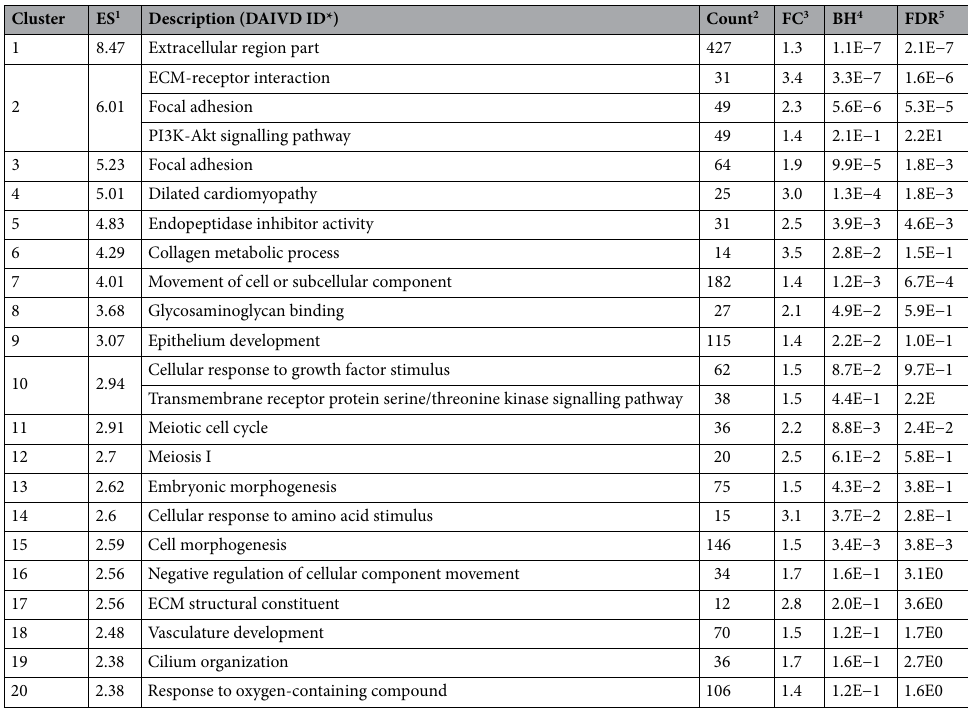
Table 1. Functional annotation clusters identified during the PrF-PF transition in domestic cat using DAVID. The top 20 categories grouped by similar GO and KO terms are listed. The full list containing 137 identified clusters is found in Supplementary Data 2, “DAVID PrF-PF”. 1 enrichment score, geometric mean of member’s P values of the corresponding annotation cluster in -log10 scale of the annotation cluster; 2 number of gene counts, 3 Fold-change, 4 Benjamini-Hochberg value, and 5 false discovery rate ( P value adjusted). *internal gene ID defines a unique gene cluster belonging to a gene